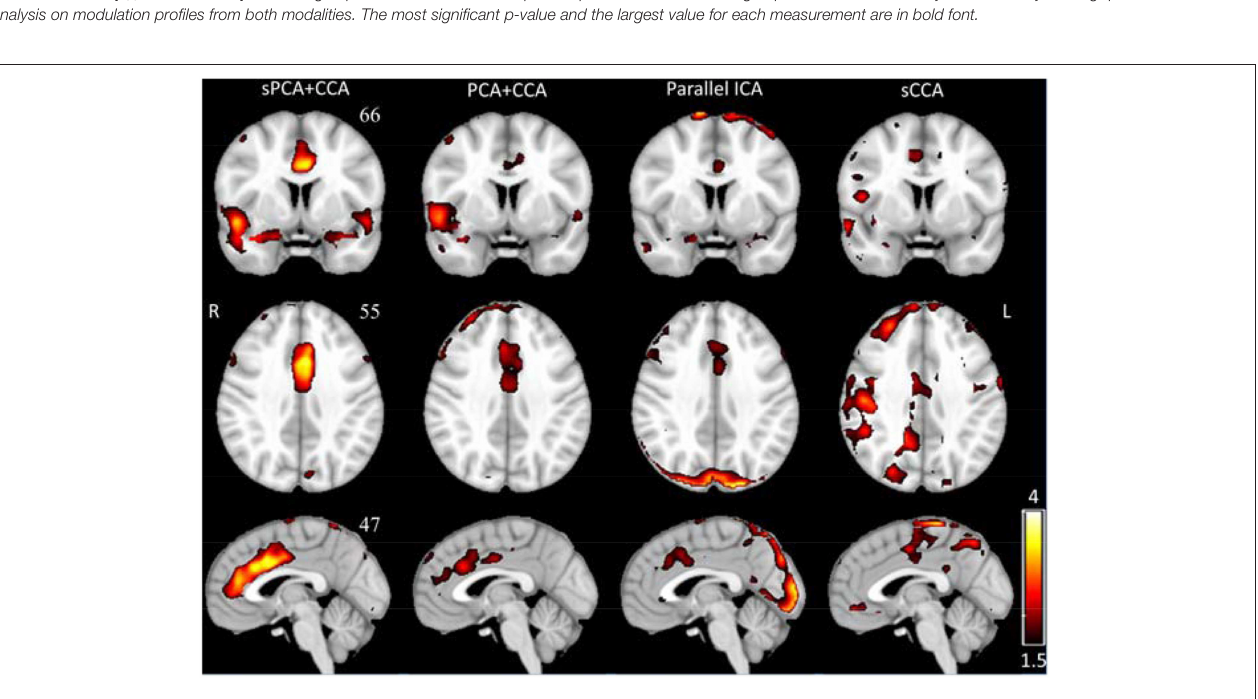
FIGURE 6 | The most significant disease-related ECM z-score maps from sPCA + CCA, PCA + CCA, parallel ICA and sCCA. Maps are displayed in radiological convention (right is left and vice versa). All spatial maps are thresholded at z ≥ 1.5 except the map from parallel ICA that is thresholded at z ≥ 1. Parallel ICA would not show the anterior cingulate cortex if the map is thresholded at z ≥